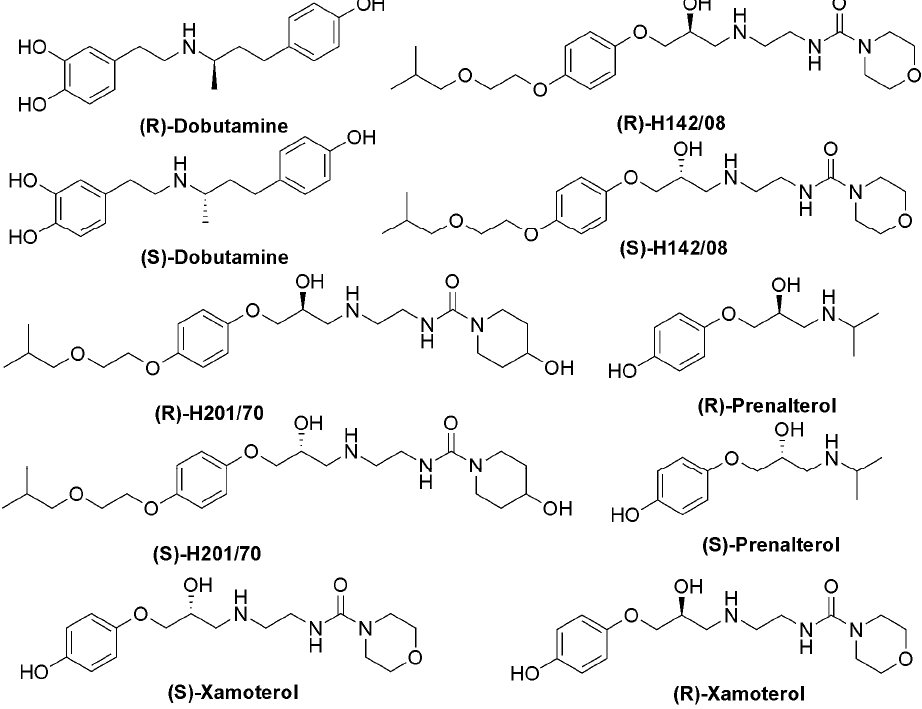
-agonists used to map with 1